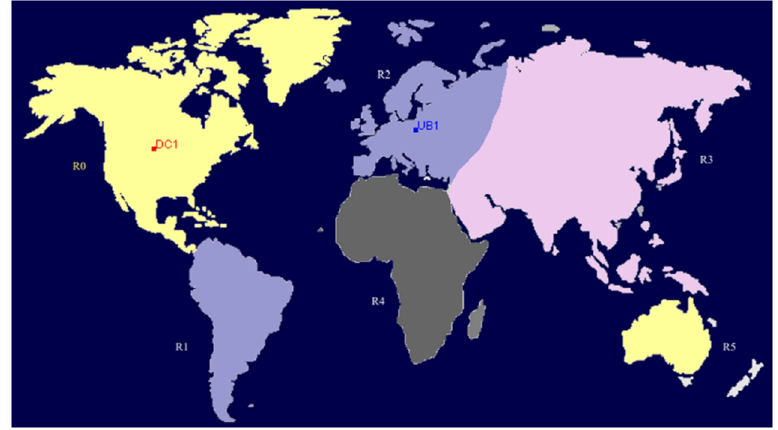
Figure 4. The geographically distributed data centers [12].